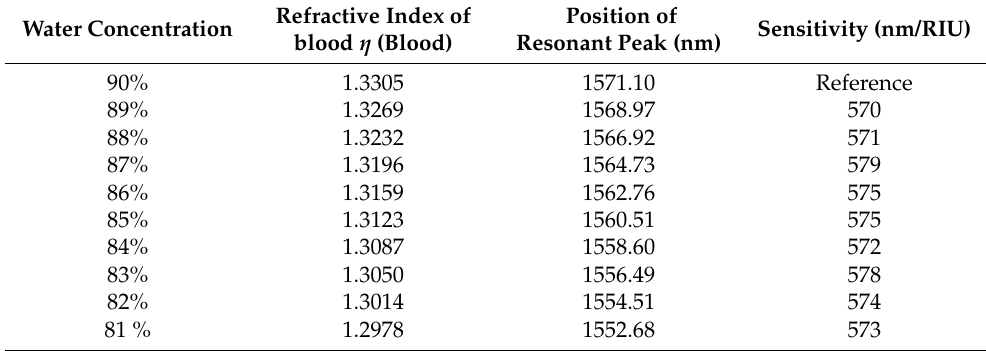
Table 6. Position of resonant peak and sensitivity of the design structure with change in the refractive index of